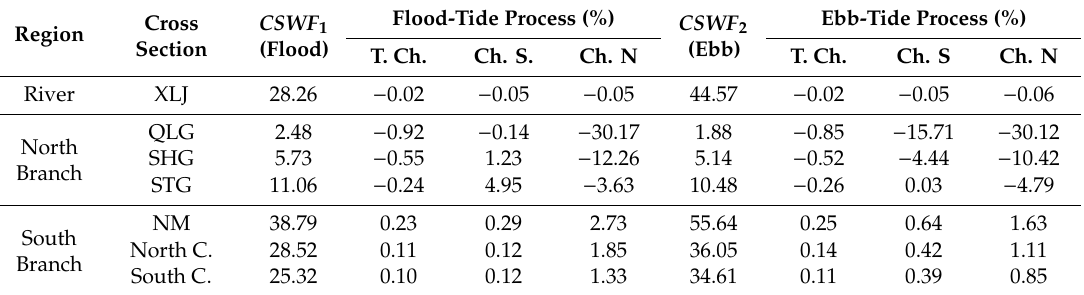
Q peak 1 and Q peak 2 represent the cross-sectional discharge peaks (with no regulation), respectively, during the flood-tide and the ebb-tide periods (unit: × 10 4 m 3 / s). Table 4. Variations of cross-sectional water fluxes ( CSWF ) in Yangtze Estuary after GYS Regulation. CSWF 1 Cross Region (Flood) Section River North